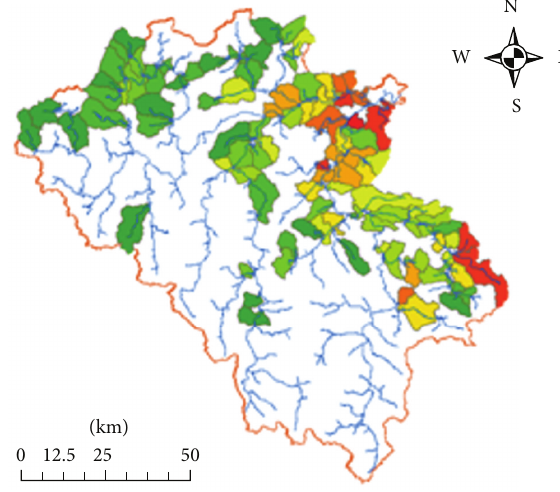
Figure 6: Population density